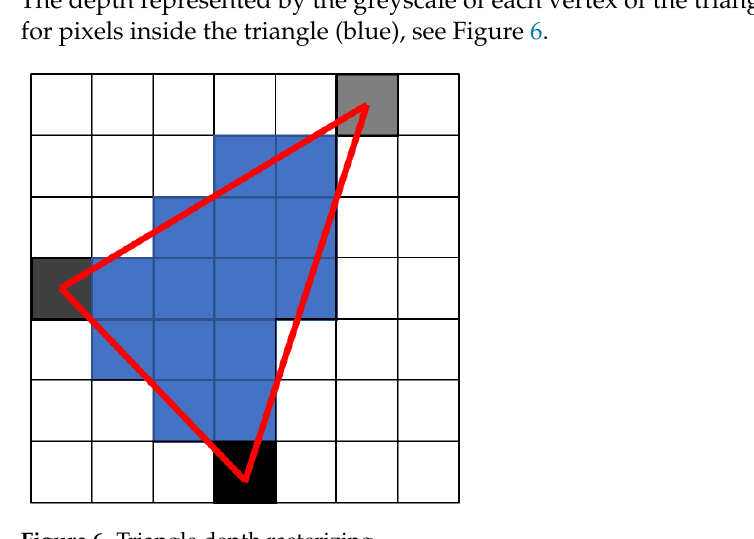
7 of 19 Algorithm 4 Viewport scale for triangle in mesh.Triangles :